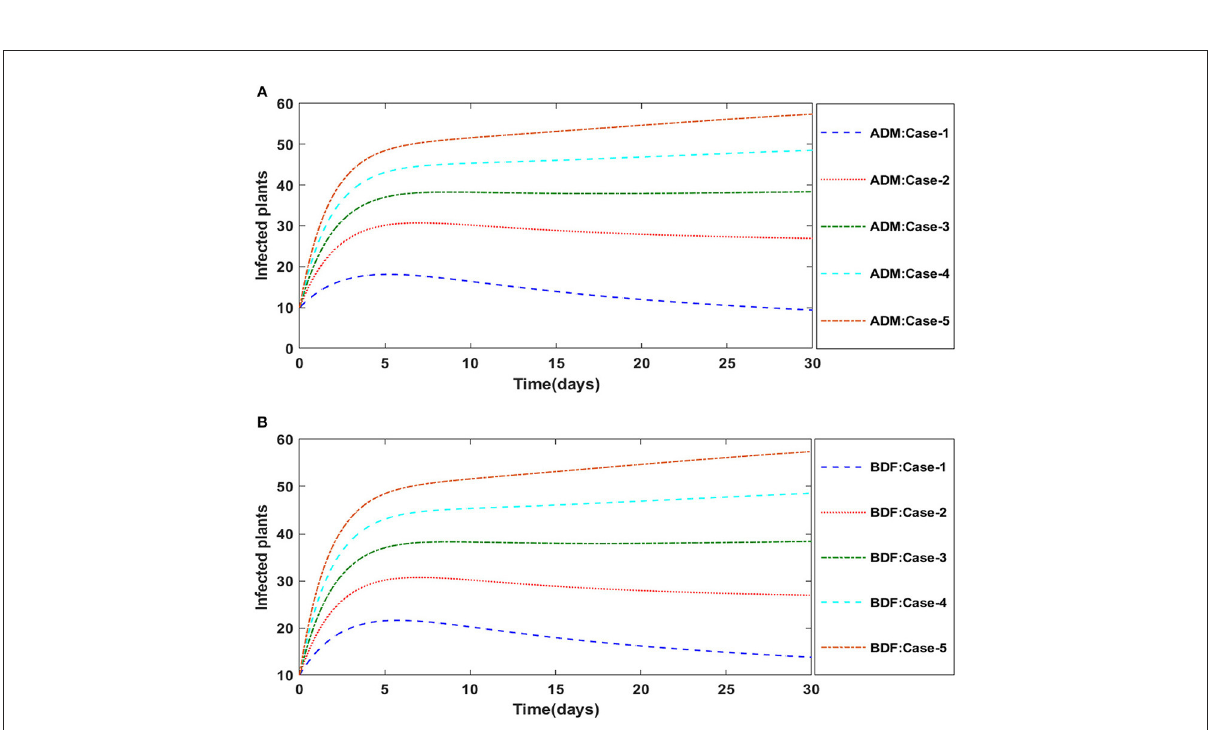
FIGURE11 (A) Dynamics of infected plants for the varition in γ using ADM for model A2. (B) Dynamics of infected plants for the varition in γ using BDF for model